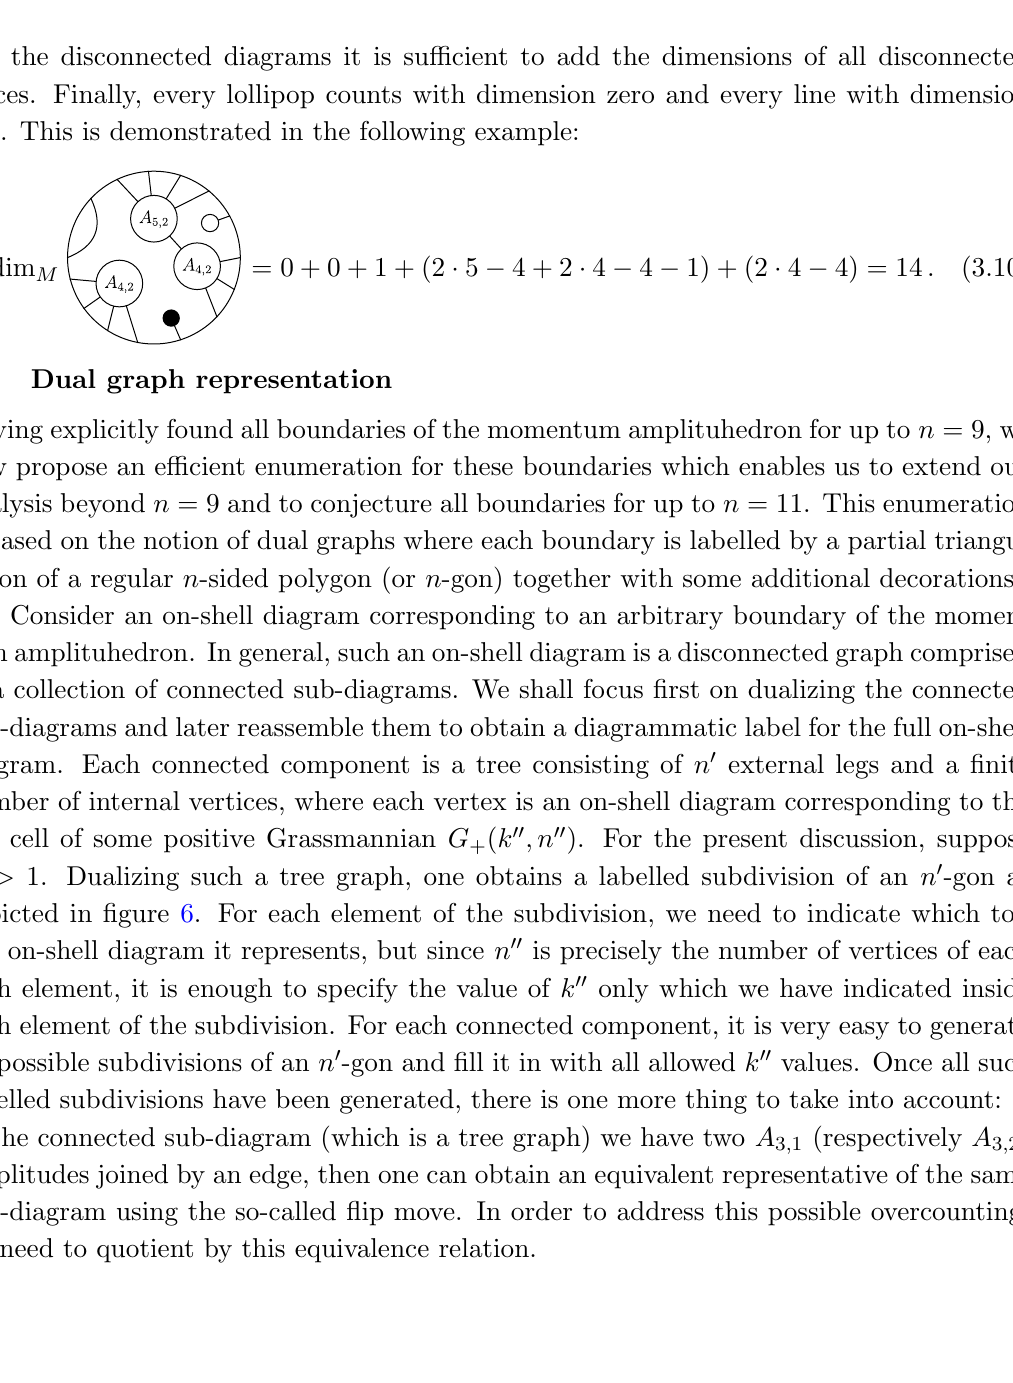
Figure 6 . Dualization of a connected component of a boundary of the momentum